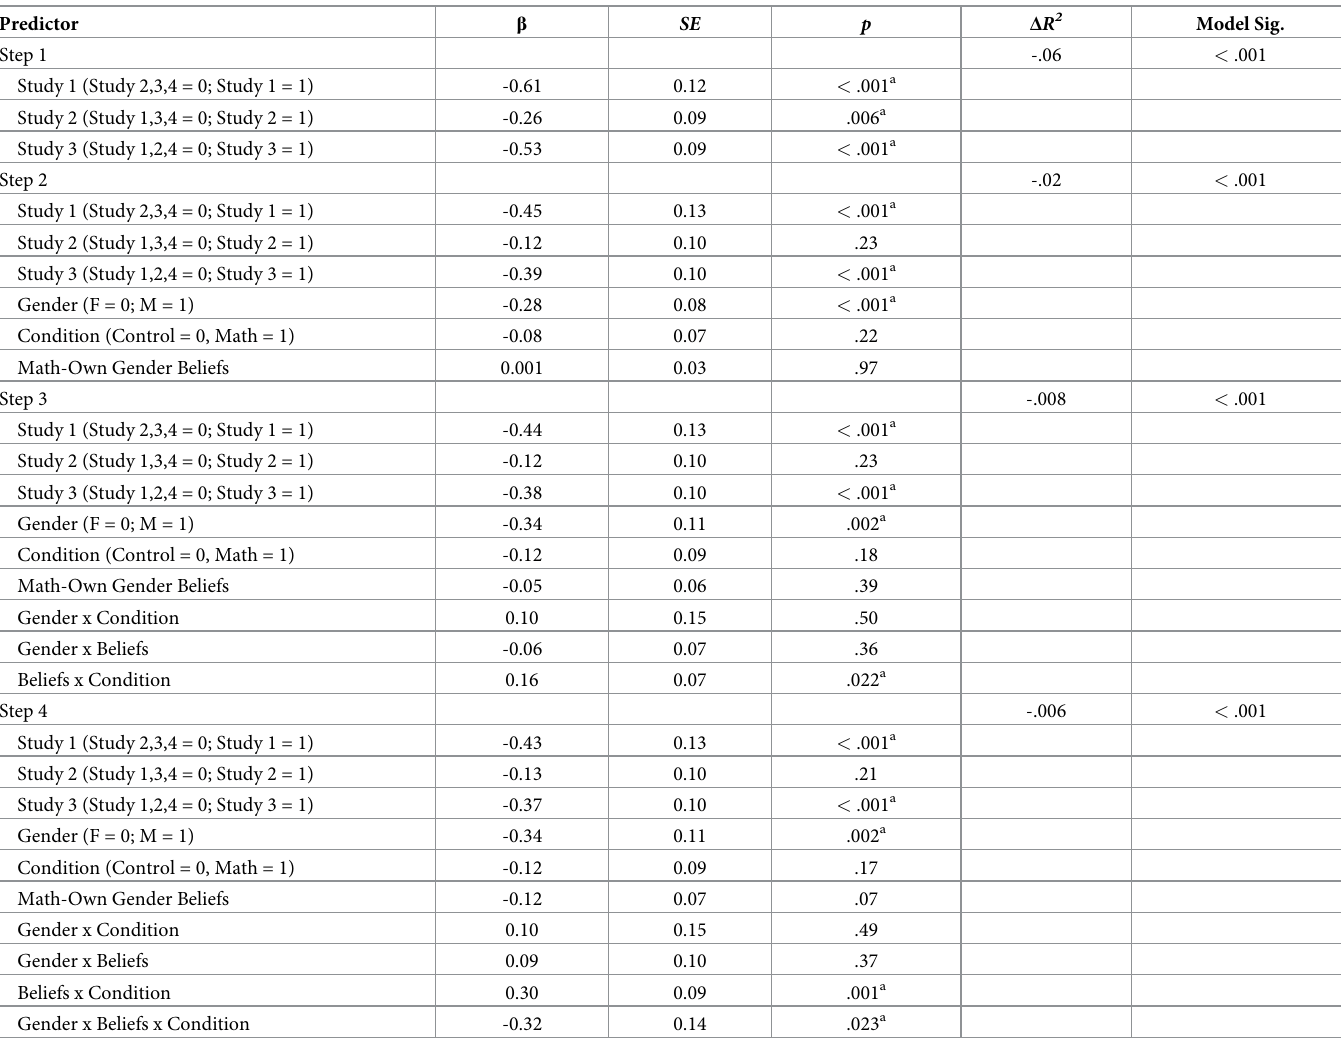
Table 2. Gender and math-own gender beliefs predicting ANS